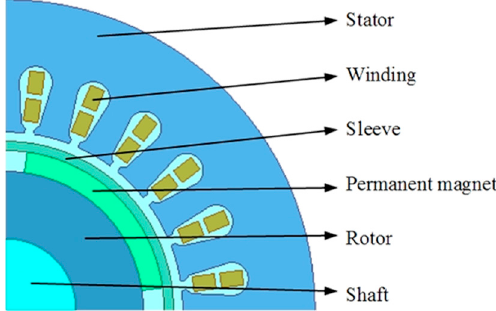
Figure 6. 2D model diagram of cryogenic permanent magnet brushless DC motor.